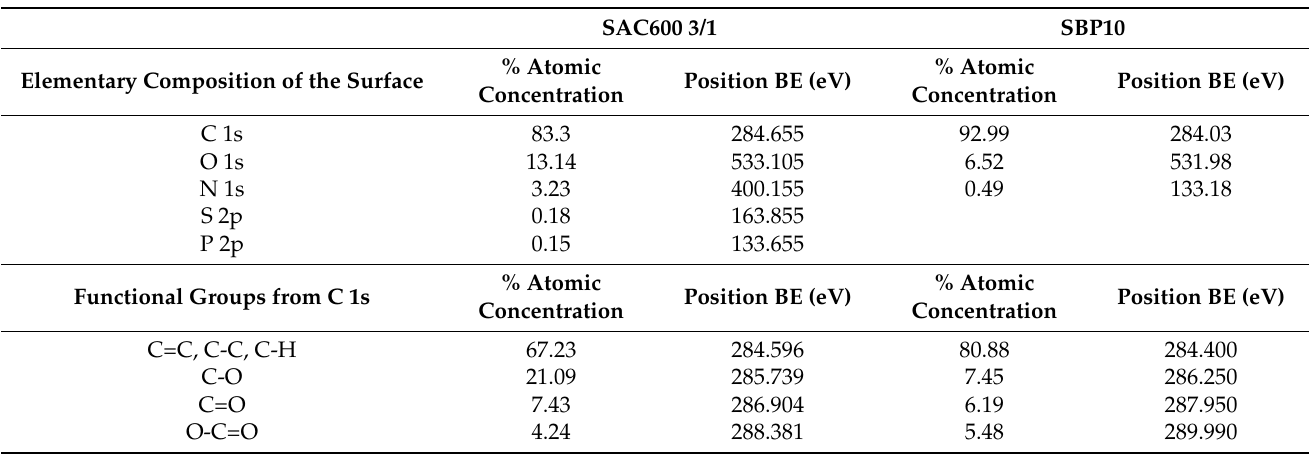
Table 4. Atomic concentration (%) and position BE (eV) of the chemical elements and functional groups present on the surface of the SAC600 3/1 and